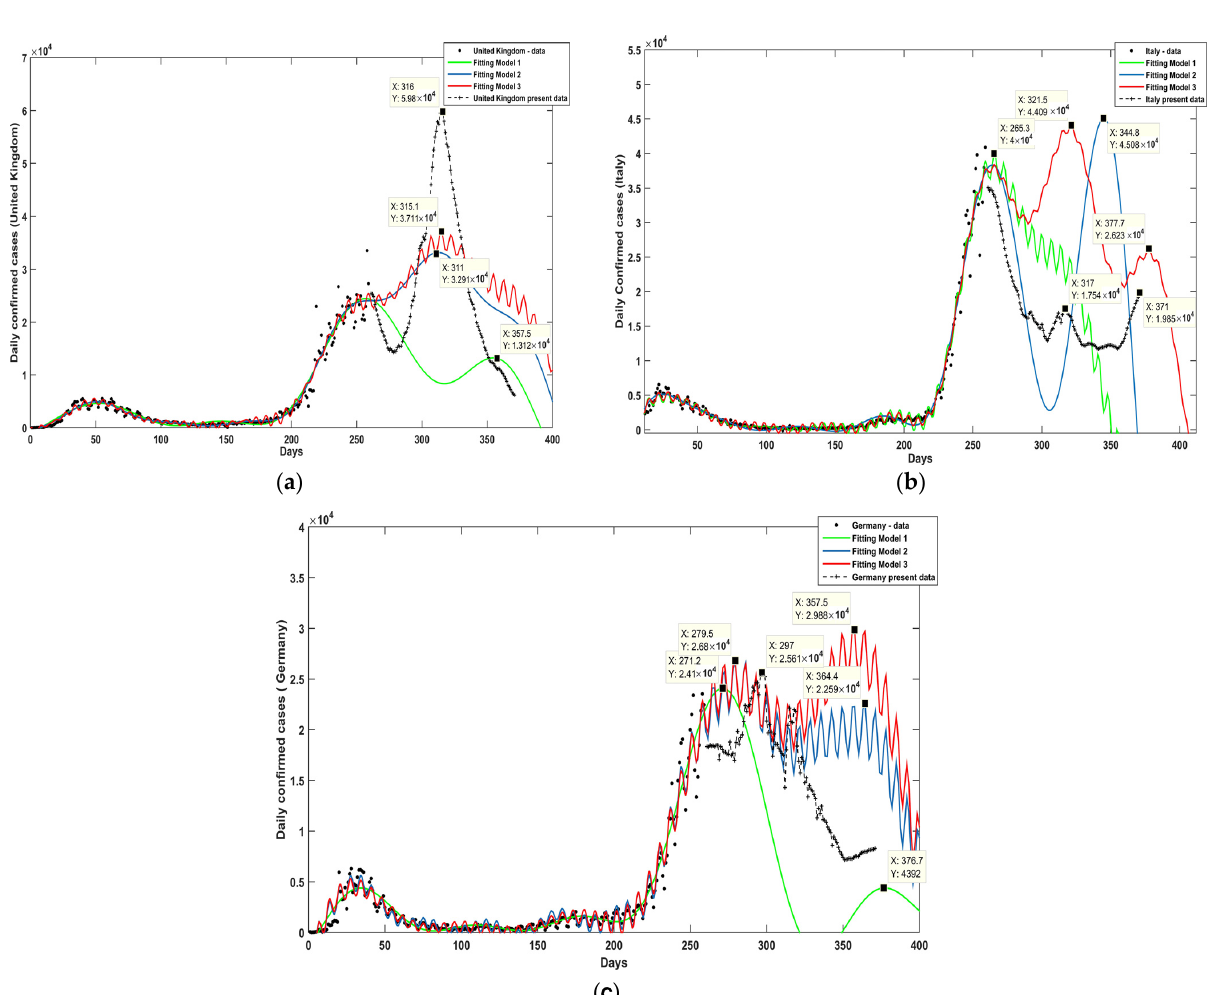
Figure 3. Curve fitting models for daily confirmed cases for second category countries: ( a ) curve fitting models for United Kingdom data; ( b ) curve fitting models for Italy data; ( c ) curve fitting models for Germany data.